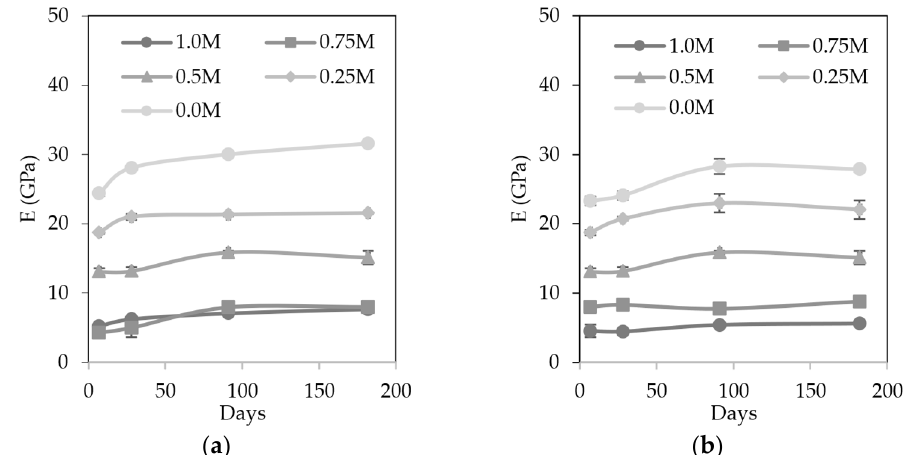
Figure 12. Dynamic modulus of elasticity of: ( a ) OAA mortars and ( b ) CAA mortars.